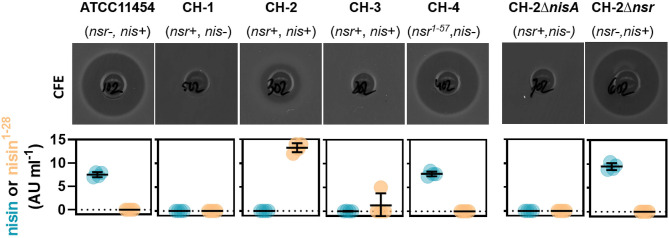
Impact of nsr genotype on bactericidal activity and nisin production. Top row: Well diffusion assays showing the antibacterial activity of CFS collected from indicated strains grown in GM17 for 16 h against the nisin-sensitive L. lactis strain Wg2. Bottom row: Graphs displaying nisin A and nisin1−28 concentrations in CFS collected from indicated strains grown in GM17 for 24 h as measured using HPLC-MS/MS.